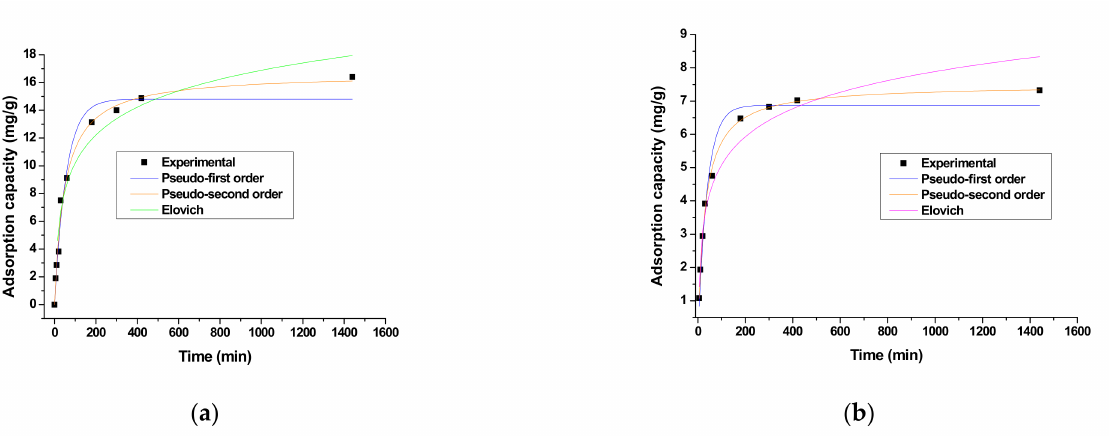
Figure 3. Sulfate adsorption kinetics for ( a ) B 1:1 and ( b ) MC.